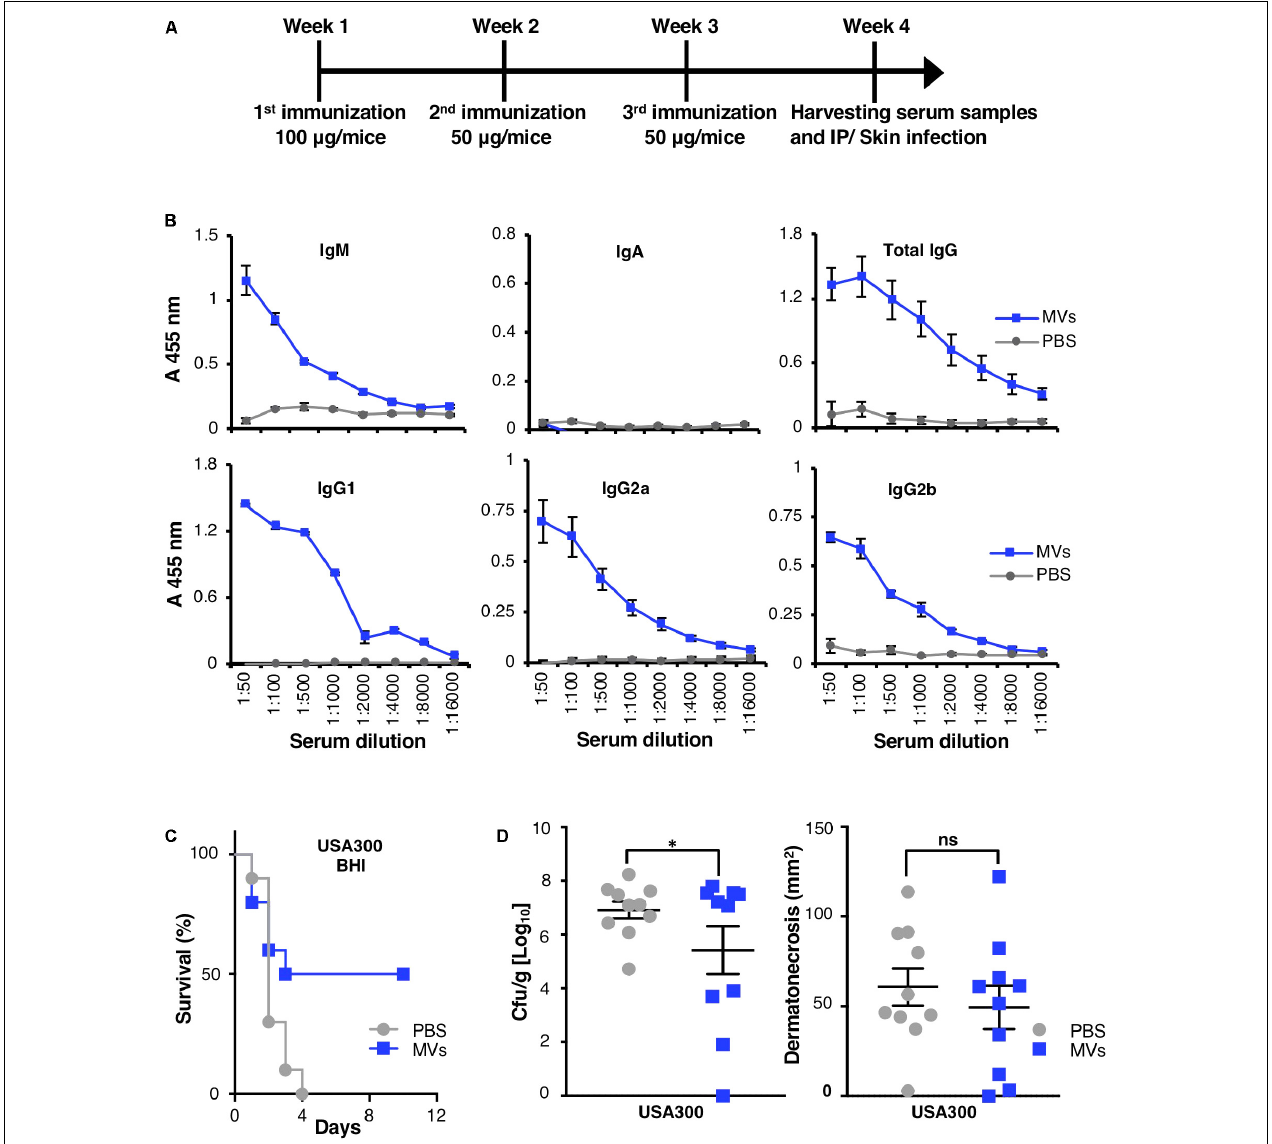
FIGURE 4 | MVs-immunized mice developed IgM and IgG subclasses and were protected against live S. aureus MRSA challenge. MVs were isolated from MRSA grown in BHI. (A) The diagram represents timeline for vaccination procedure and S. aureus challenges. (B) Titers of anti-MVs IgM, IgA, IgG, and of IgG subclasses IgG1, IgG2a, and IgG2b were measured in female BALB/c mice immunized intraperitoneally with MRSA-derived MVs or with PBS. Serum was collected as depicted in (A) . (C) Percentage of survival of PBS- and MVs-immunized mice, which were challenged intraperitoneally with S. aureus . (D) Bacterial load per skin abscess (left panel) and abscess size (right panel) was measured in PBS- and MV-immunized mice 3 days after subcutaneous infection. Data correspond to one experiment performed with 10 mice/group (mean ± SEM). The significance is indicated by asterisks ( ∗ ): ∗ P < 0.05. ns, no significant